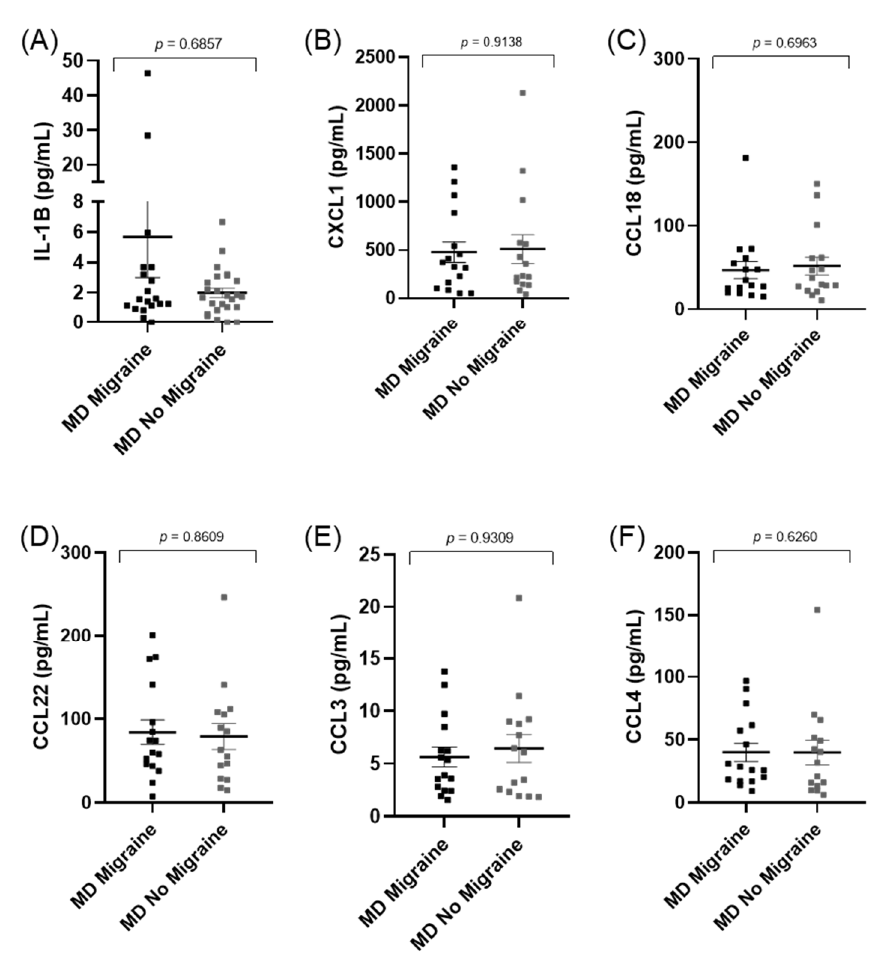
Figure 2. Scatter plots showing cytokine and chemokines levels in patients with MD ( A – F ), stratified according to the presence of migraine.